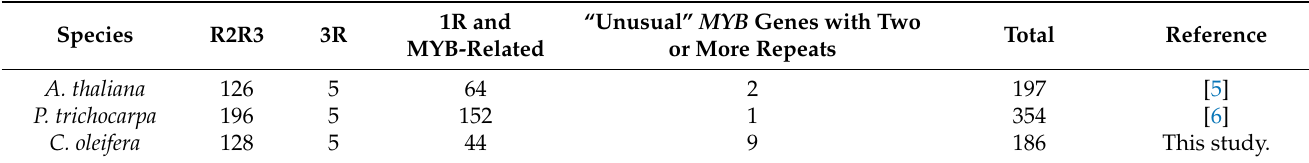
Table 1. Numbers of MYB transcription factors in three plant